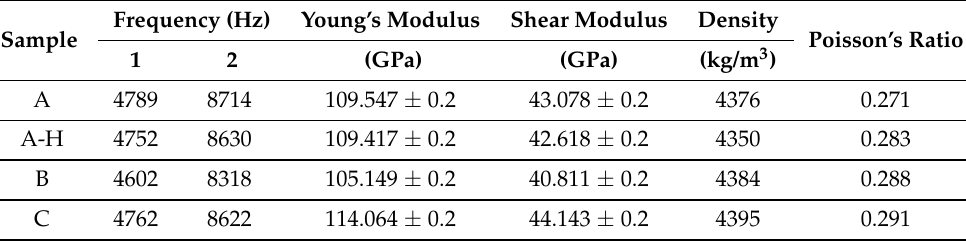
Table 2. Average properties of each material samples.